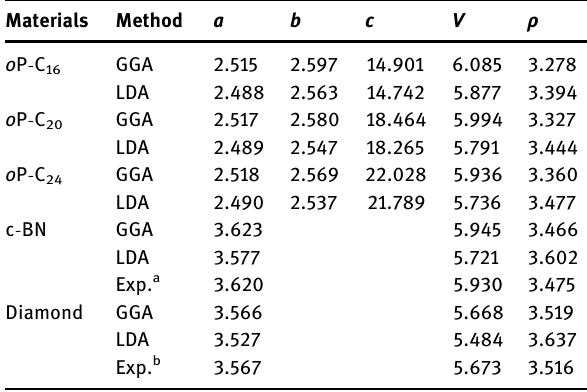
Table 1: Obtained lattice constants ( Å ) , cell volume/atom V ( Å 3 ) , and density ( g/cm 3 ) for o P - C 16 , o P - C 20 , o P - C 24 , c - BN, and